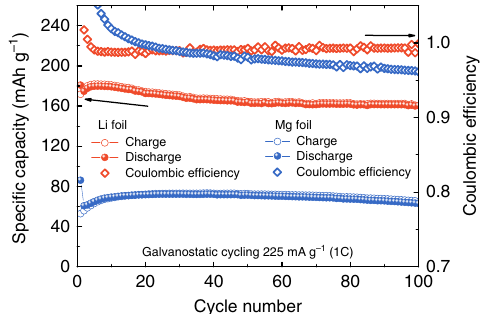
Fig. 1 Electrochemical performance of Li – and Mg – PAQS batteries. Speci fi c capacity (left y -axis) and Coulombic ef fi ciency (right y- axis) for PAQS in Li (red) and Mg (blue)